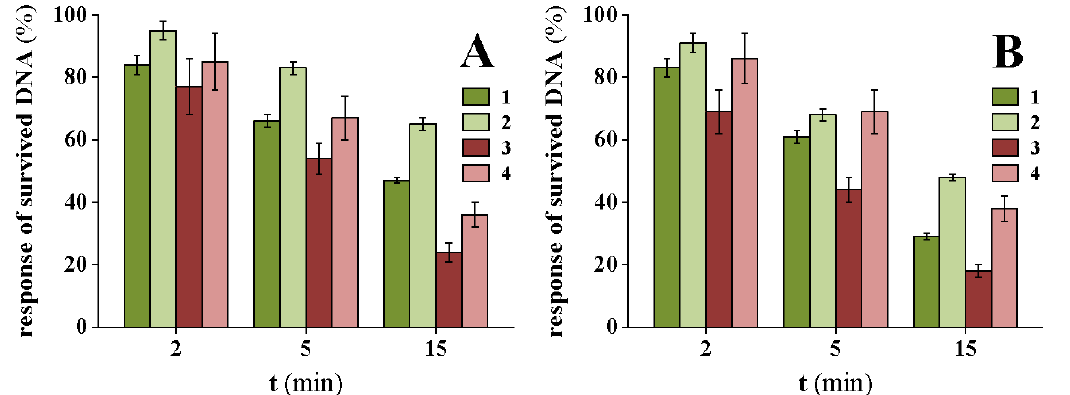
Figure 4. Antioxidant activity of black tea (A) (measured at the NAF/DNA/SPCE) and coffee (B) (measured at the CHIT/DNA/SPCE) evaluated by the comparison of the biosensor responses after the incubation in the 1:1 (v/v) mixture of the cleavage agent and PBS (1 and 3) and in the 1:1 (v/v) mixture of the cleavage agent and the beverage (2 and 4) for a given time. Biosensor responses: (1) and (2) Δ I , (3) and (4) Δ R , respectively. et Table 1. Comparison of the DNA/SPCE, NAF/DNA/SPCE, and CHIT/DNA/SPCE biosensor responses obtained after the incubation with the •OH cleavage agent for a given time.